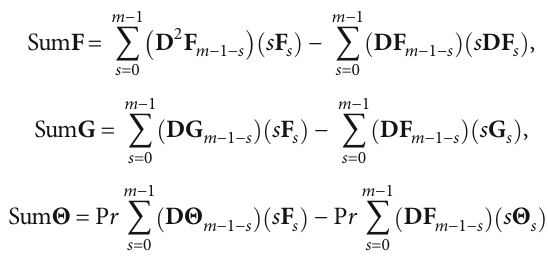
against increasing order ð m Þ of LSPM series approximation when n = 0 : 5, K = m